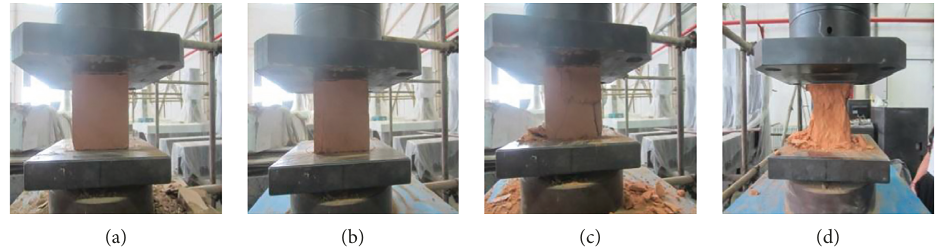
Figure 5: Progress of a red soil cube compressive strength test. (a) Loading. (b) Cracking. (c) Damage. (d) Completely destroyed.